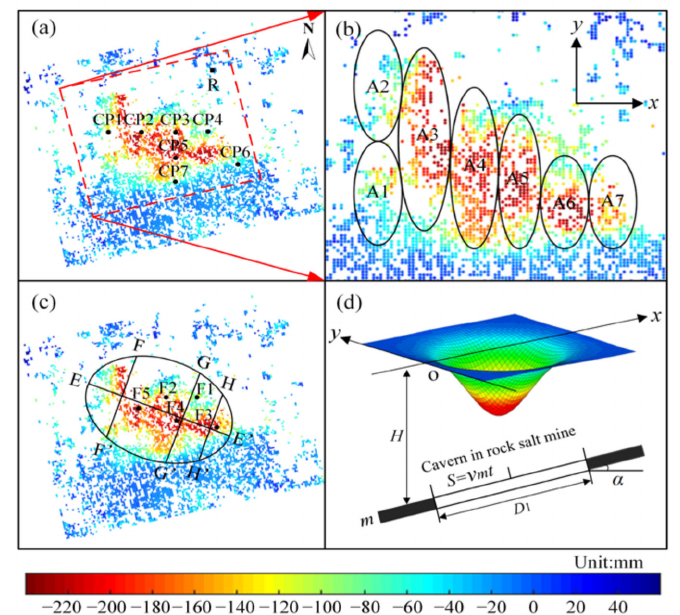
Figure 11. Schematic map of sub-settlement funnels distribution (with the settlement at 15 August 2017 generated via SBAS as the background): ( a ) the leveling points; ( b ) distribution of the seven sub-settlement funnels; ( c ) the distribution of the traverse-longitudinal profiles of the funnels; ( d ) 3D version of the mining coordinate system.